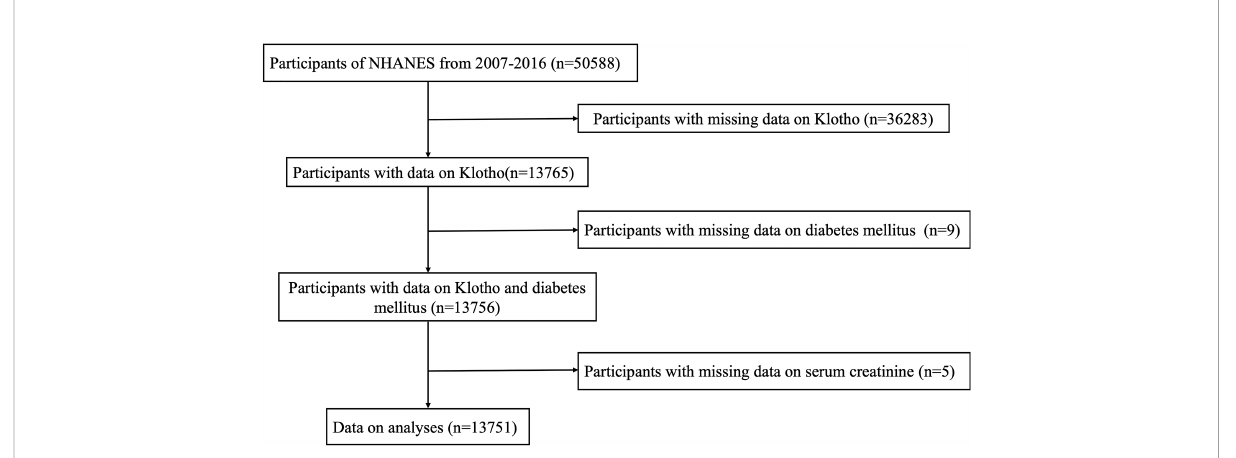
FIGURE 1 Flow chart of the study population. NHANES: the National Health and Nutrition Examination